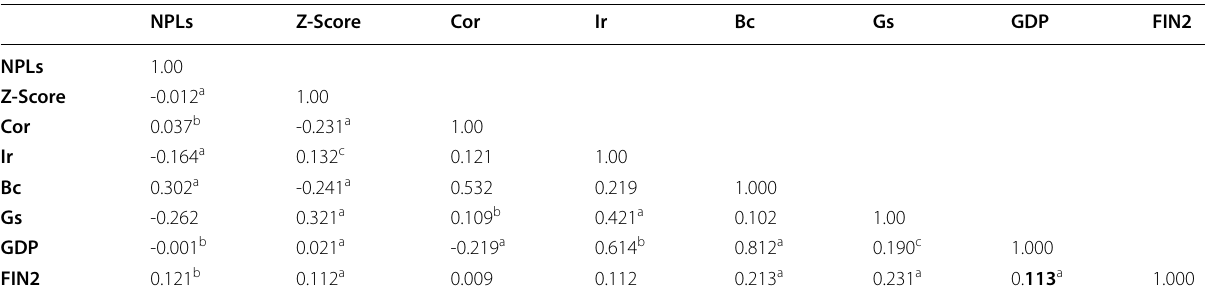
Table 5 Correlation